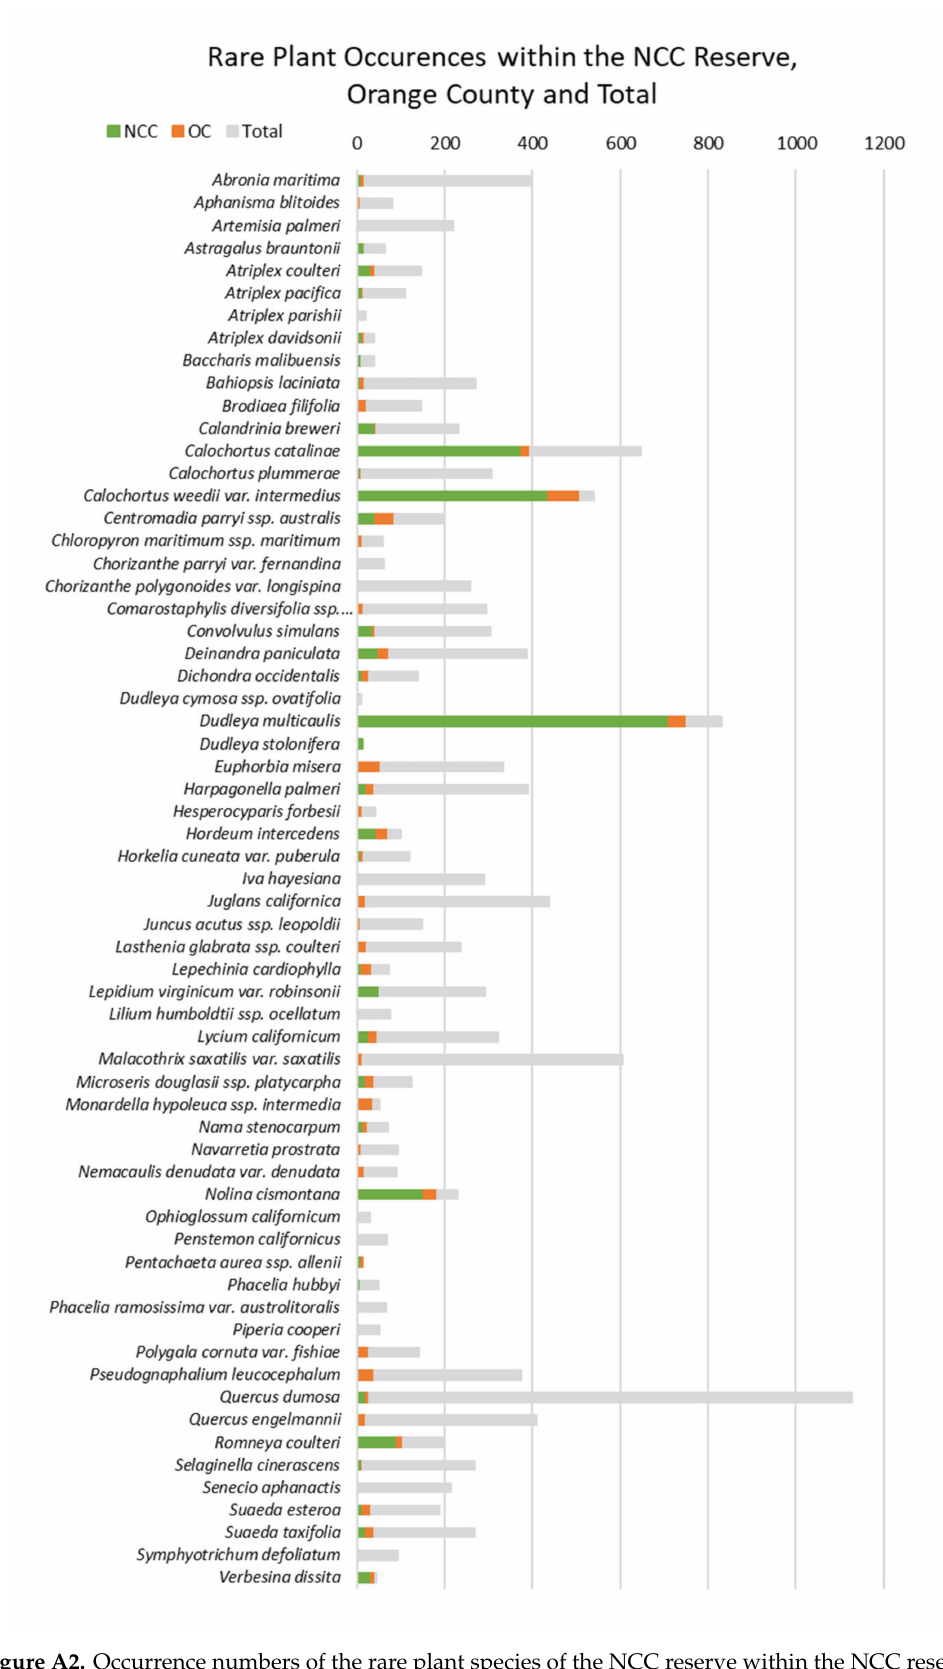
Figure A2. Occurrence numbers of the rare plant species of the NCC reserve within the NCC reserve (green), Orange County (orange), and each species total occurrences